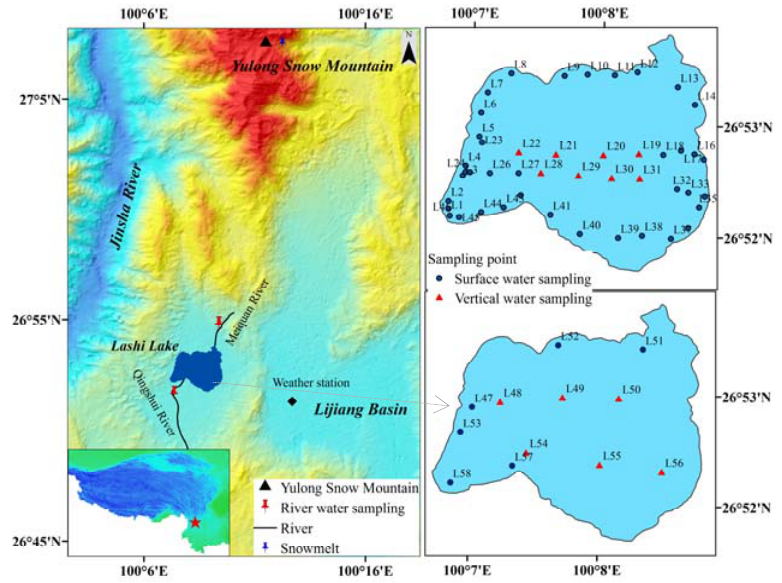
Figure 1. Location of the study area and sampling point sites.